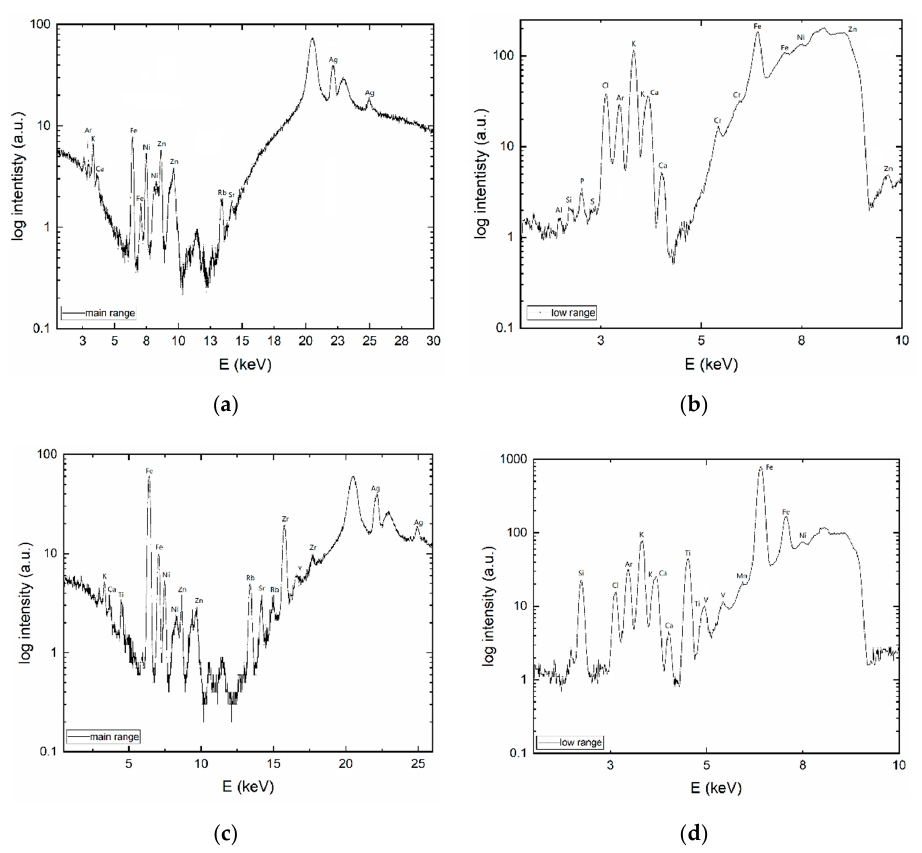
Figure 2. XRF of bamboo biomass (BC1) in ( a ) BC1 main range, ( b ) BC1 low range, ( c ) BC2a main range and ( d ) BC2a low range.